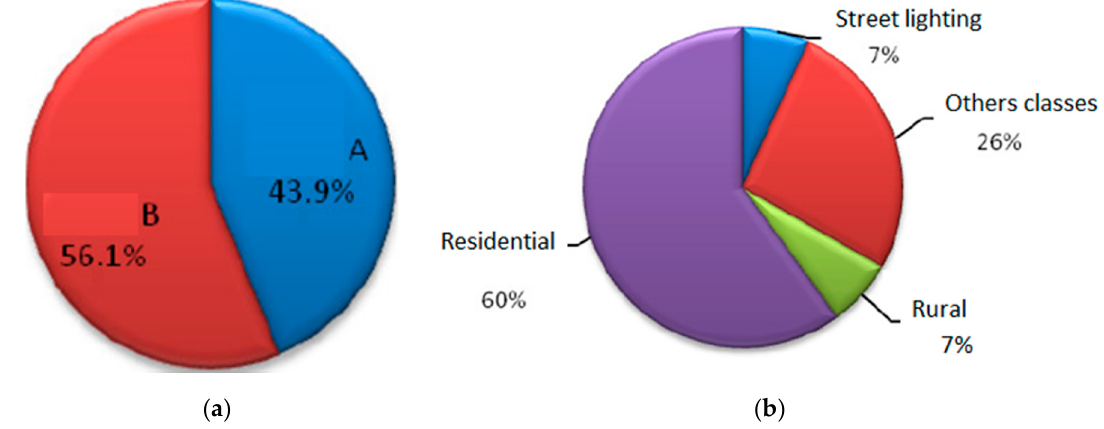
Figure 2. Brazilian power market. ( a ) Group composition (MWh) and ( b ) Consumer market. Source: ELETROBRAS [47].